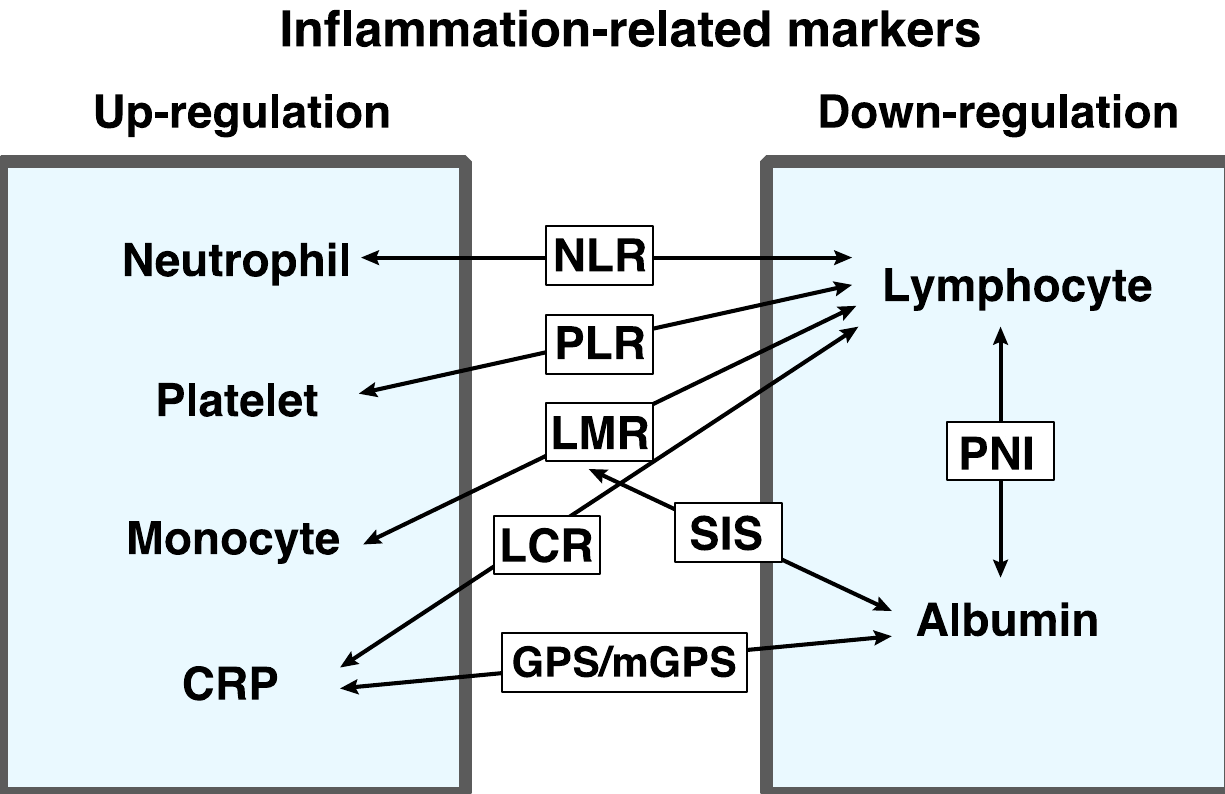
Figure 1. Overview of the inflammation-related markers. Inflammation-related serum parameters can be classified into the two groups: upregulation variables in disease progression (neutrophil, platelet, monocyte, and C-reactive protein (CRP)), and downregulation variables in disease progression (lymphocyte and albumin). The combination of the two of them can be used as inflammation-related markers.